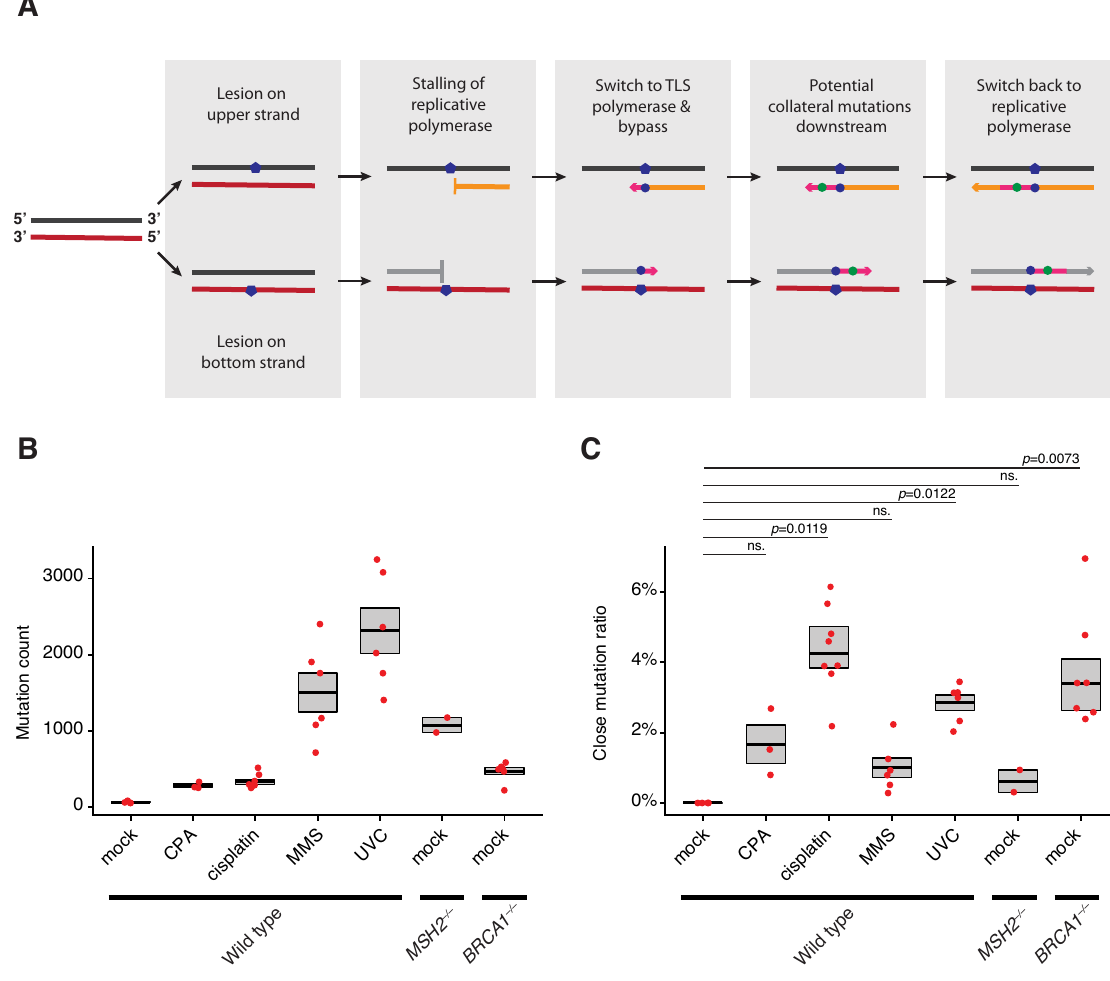
Fig 1. Close mutation pairs are associated with specific mutagenic treatments. (A) Model of collateral mutagenesis [14]. After the stalling of replicative polymerases (orange and grey arrows) at lesions, polymerase switch may occur. Downstream of the original lesions, TLS activity (magenta arrows) will induce collateral mutations, before switching back to replicative enzymes. Due to 5’-3’ orientation of DNA polymerisation, we expect collateral mutation to the 5’ if the lesion was on the upper strand (upper row), and to the 3’ if the lesion was on the bottom strand (bottom row). (B) Single base substitution (SBS) counts after the indicated mutagenic effects. (C) Ratios of close mutations. Close mutations were defined as mutations with any neighbouring SBS closer than 100 bps, but without dinucleotide mutations (i.e. mutations that are directly adjacent). In (C, D) each red marker represents an independent mock or mutagen treated clone, and the box shows mean and standard error